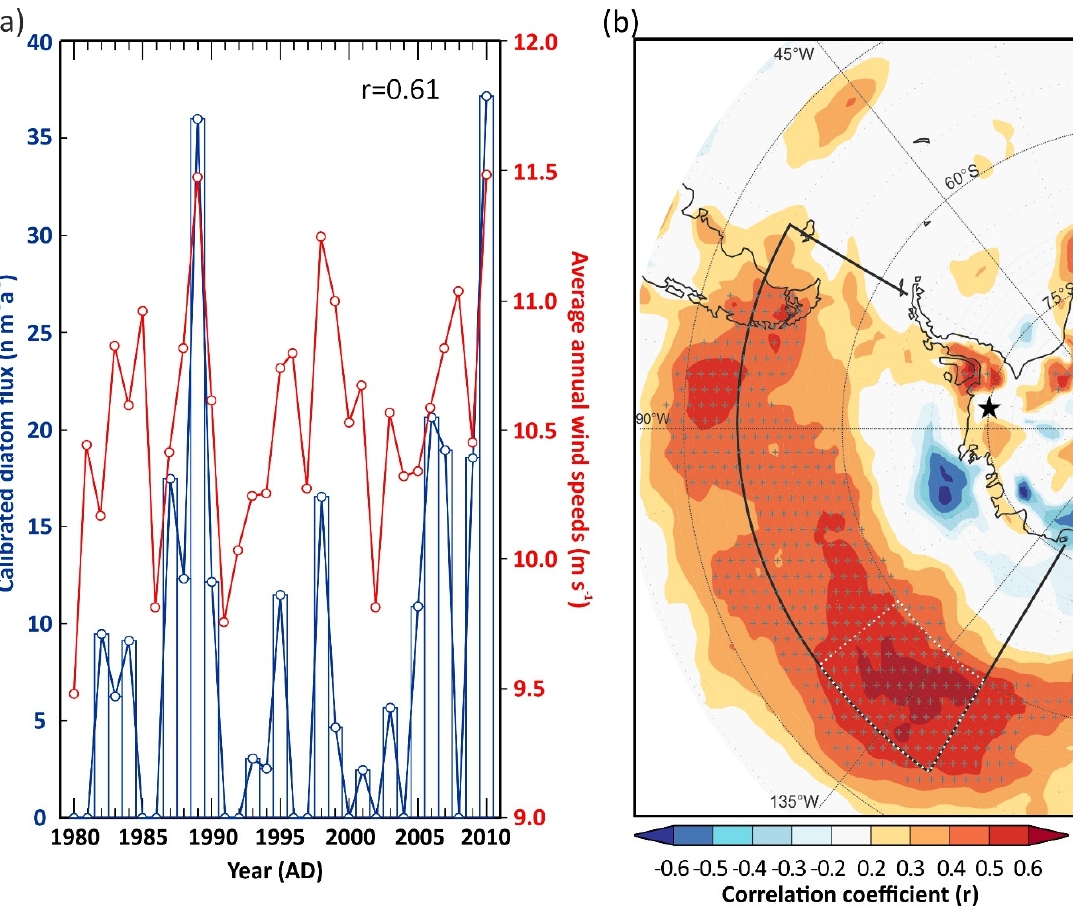
Figure 8. Correlation of calibrated diatom flux (n m − 2 a − 1 ) and average annual wind speed anomalies (ms − 1 ) for 1980–2010. ( a ) Plot of diatom flux (blue) and average annual wind speed anomalies (red) ( p < 1%); ( b ) correlation (detrended) analyses of diatom flux and annual wind speed anomalies. Grey hatching indicates region of significant ( p < 5%) positive correlation (max r = 0.6); black star indicates the location of the Ferrigno ice core, black outline replicates the demarcation of the Amundsen and Bellingshausen Seas given in Figure 1 and white dotted margin indicates the approximate region for which winds were averaged for (a).